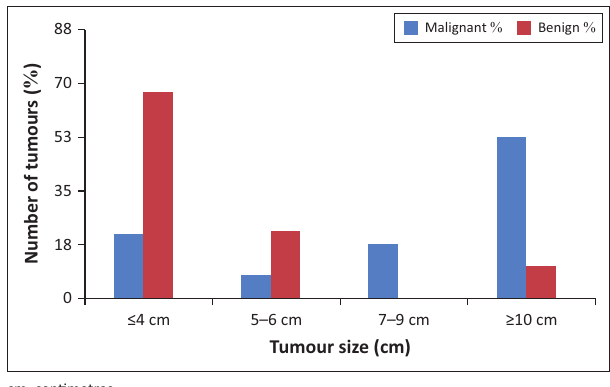
FIGURE 2: Comparison of computed tomography tumour size between renal cell carcinomas and benign lesions. TABLE 3: Sensitivity, specificity, positive predictive value and negative predictive value of computed tomography scan for tumour staging. Parameter Sensitivity ( % )